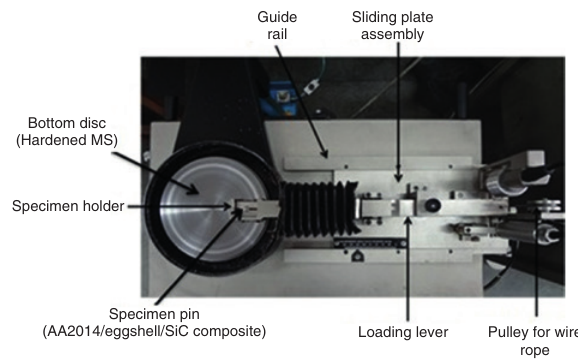
Figure 3: Experimental set up of the pin-on-disc machine with specimen pin (AA2014/eggshell/SiC composite).